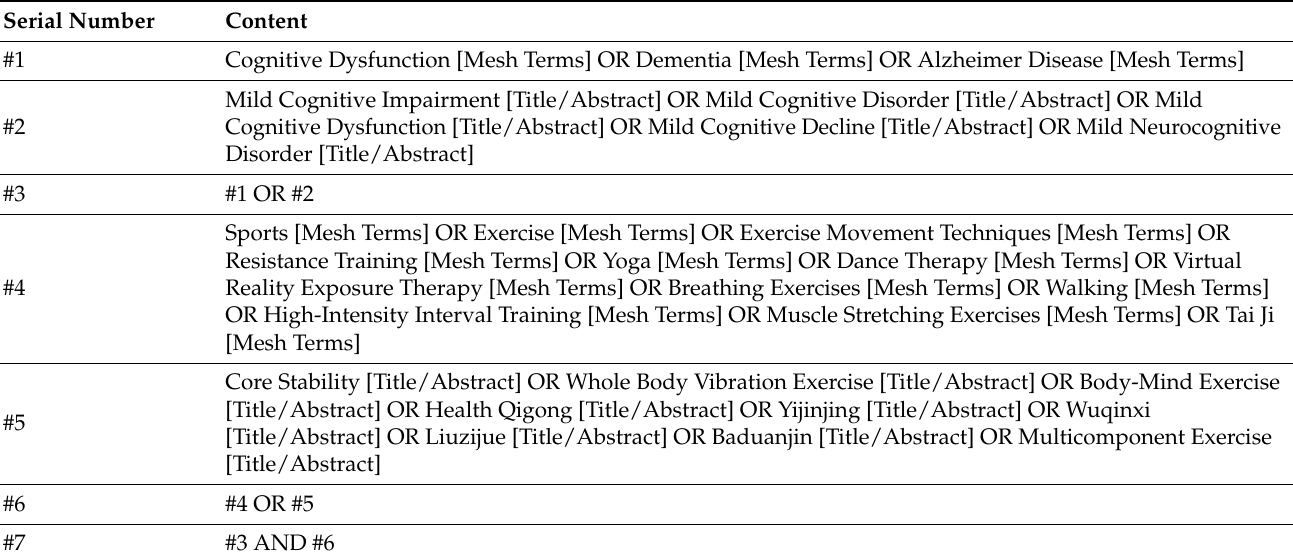
Table 1. PubMed search